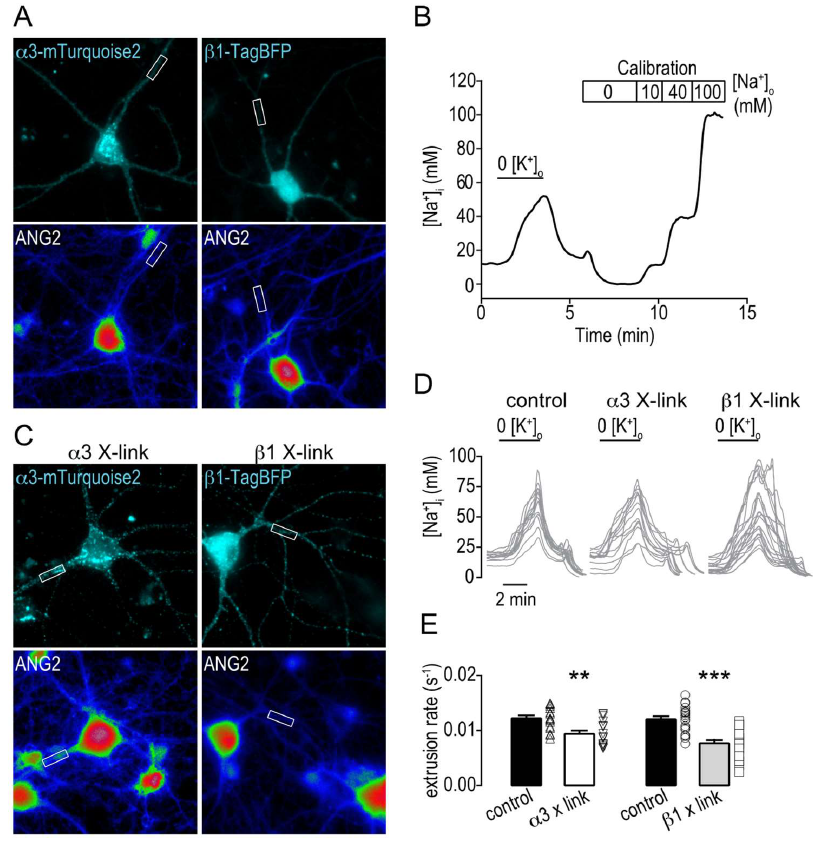
Figure 4. Altered membrane dynamics and clustering of the Na,K-ATPase affects intracellular Na + clearance. ( A ) Representative images of hippocampal neurons in cultures expressing α3-mTurquoise2 or β1-TagBFP and loaded with Asante Natrium Green 2 (ANG-2). The white rectangles indicate typical regions of interests for intracellular recordings of [Na + ] i . ( B ) Typical trace of [Na + ] i recordings in a single dendrite of a hippocampal neuron challenged with transient perfusion of K + -free buffer. Calibration is performed at the end of each experiment. ( C ) Representative images of hippocampal neurons in cultures expressing α3-mTurquoise2 or β1-TagBFP and loaded with Asante Natrium Green 2 (ANG-2), when subjected to antibody cross linking (X-link). The white rectangles indicate typical regions of interests for intracellular recordings of [Na + ] i . ( D ) Example traces of [Na + ] i recordings in single dendrites of hippocampal neurons challenged with transient perfusion of K + -free buffer in control conditions or when subjected to antibody cross linking of α3 (α3 X-link) and β1 (β1 X-link). ( E ) Bar plots of the mean ± SEM Na + extrusion rate in control conditions (black, n = 13 dendrites 5 cells for α3, n = 19 dendrites 6 cells for β1, 3 cultures) or when subjected to antibody cross linking of α3 (α3 X-link, grey, n = 16 dendrites 5 cells, 3 cultures) and β1 (β1 X-link, grey, n = 22 dendrites 8 cells, 3 cultures). Individual data values are shown in open symbols for each group. The Na + extrusion rate was defined as the maximum Na + extrusion rate normalized by the maximum [Na + ] i value during the K + -free challenge. Significance was tested with the Mann–Whitney test. ** p < 0.01, *** p < 0.0001.